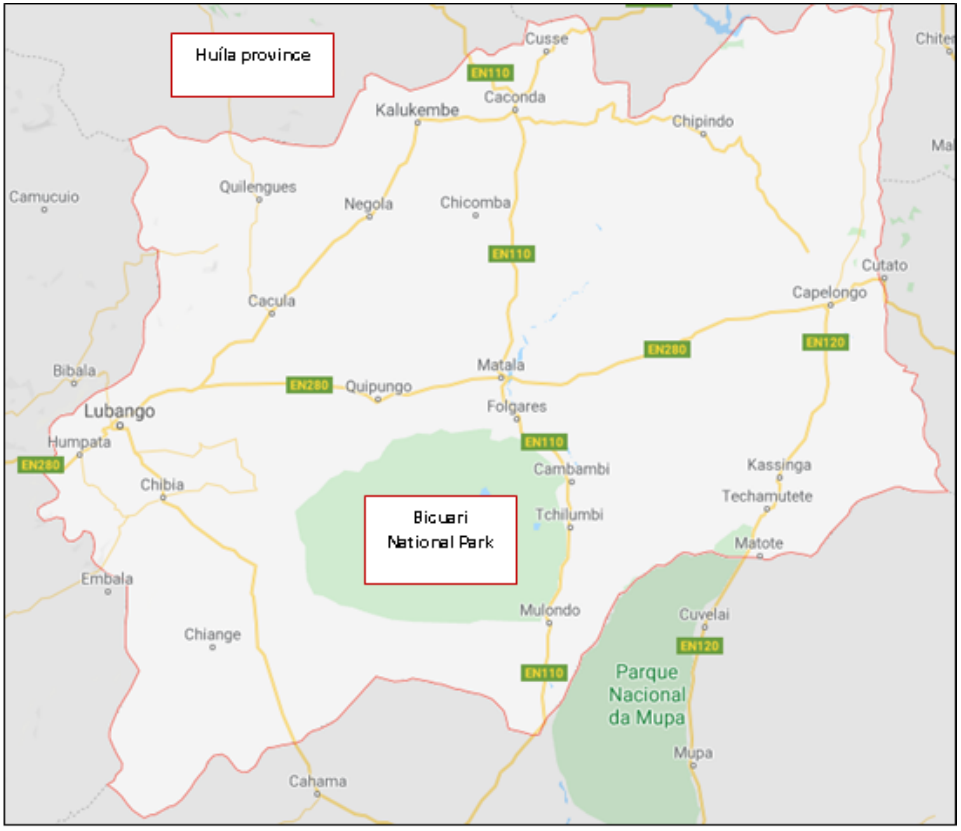
Figure 2. Study area showing Huíla province and Bicuari National Park (adapted from Google Maps, https://www.google.pt/maps/preview).